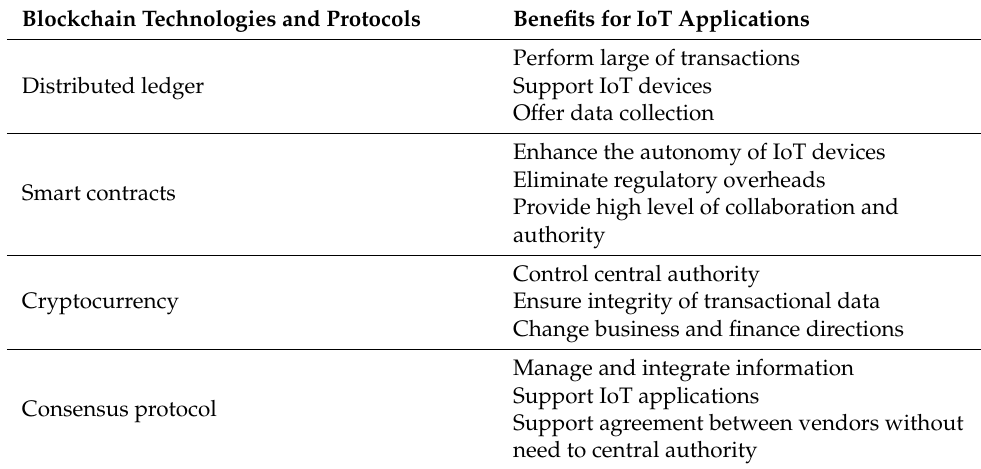
Table 3. Blockchain services and benefits for IoT